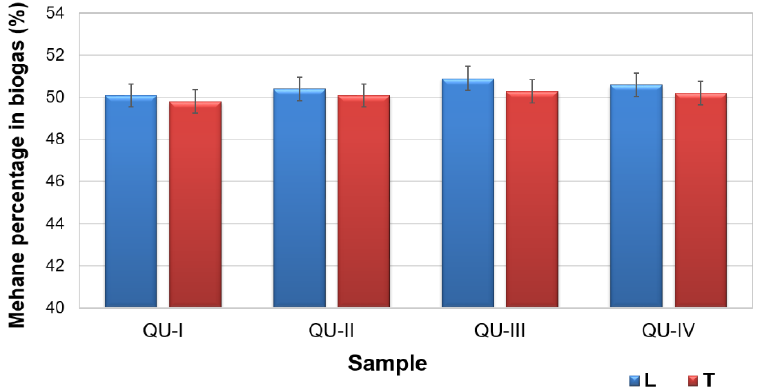
Figure 4. Volume of biogas obtained from m 3 ·Mg FM−1 (L—laboratory scale; T—technical scale).